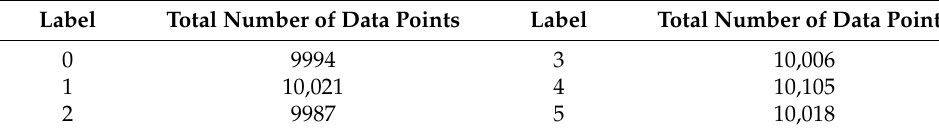
Table 10. Detailed description of the material verification